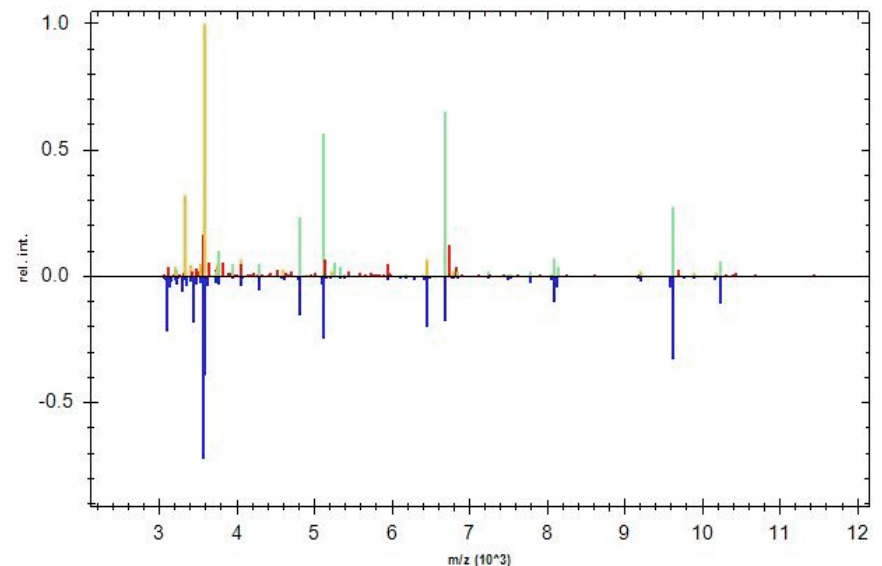
Figure 5. Graphic representation of identification of S. epidermidis (clinical strain) as S. epidermidis non-biofilm producer. In the upper half of the graph, the normalized peak list spectrum of the unknown sample is shown ( S. epidermidis SE08). In the lower half of the graph, the peak list spectrum of the MSP related to S. epidermidis 12,228 selected by MALDI Biotyper 3.0 is shown.